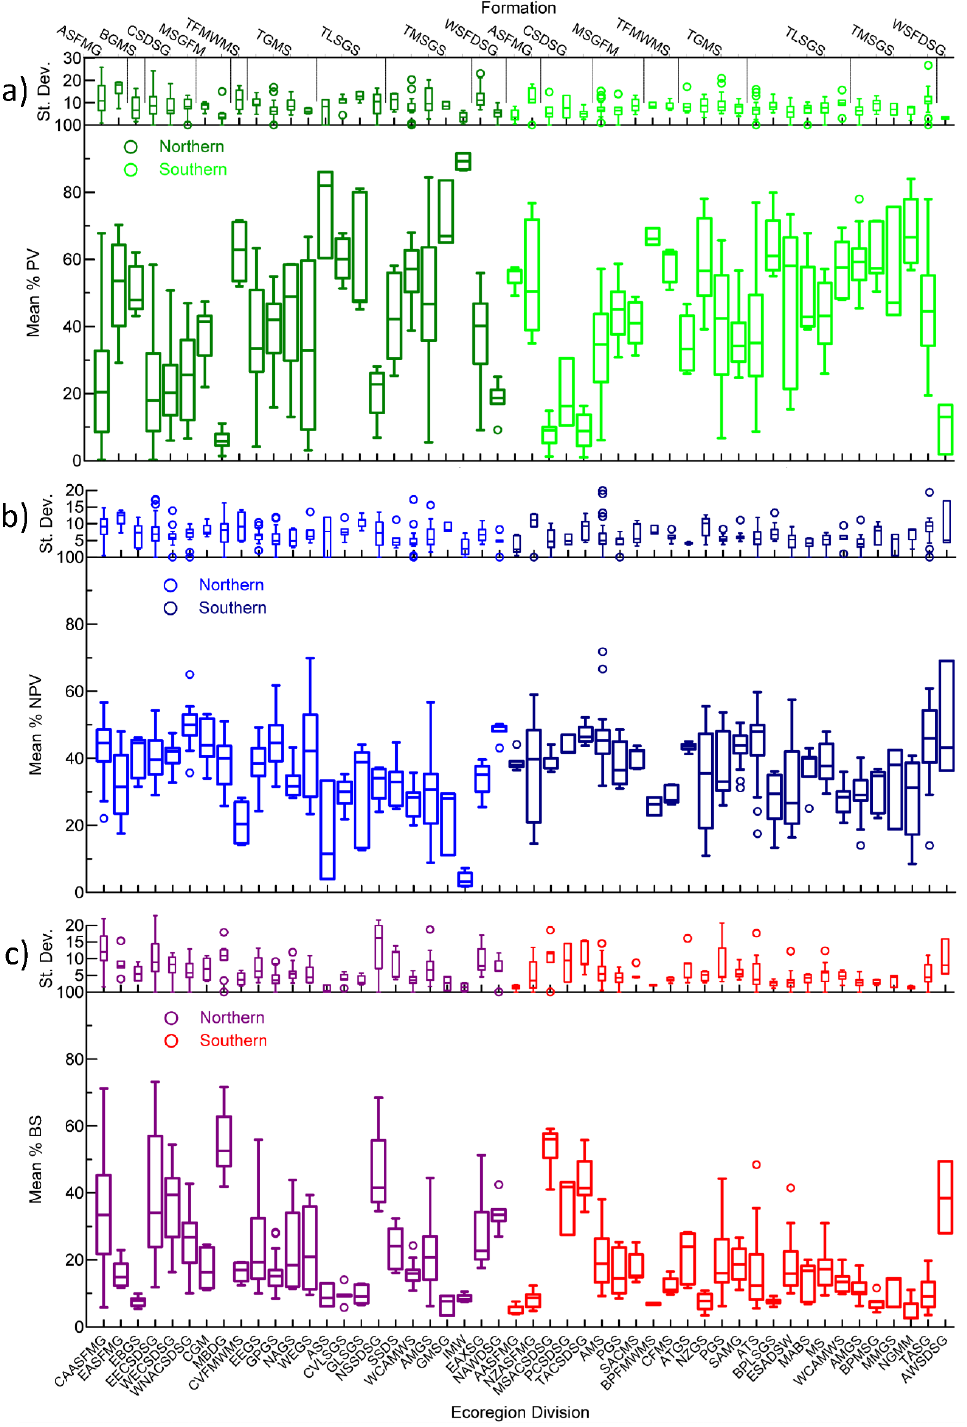
Figure 5. Fence box plots showing the medians, hinges, and inner and outer fences of average long-term vegetation fractional cover of ecoregions within World Grassland Type Divisions (listed in Table A2. ( a ) F PV ; ( b ) F NPV ; and ( c ) F BS